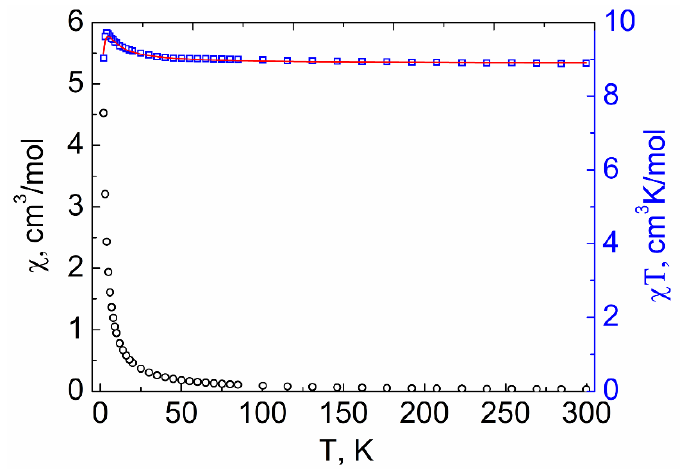
Figure 10. Temperature dependencies of the χ M T product ( □ ) and χ M ( ○ ) for compound 3 . The red line shows the values calculated using PHI [48] program.